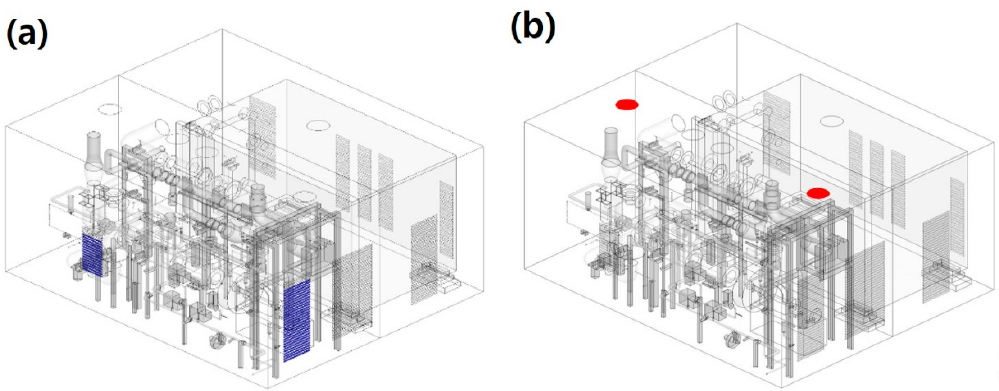
Figure 3. Conditions of the inlet and outlet of the balance-of-plant (BOP) package: ( a ) louver installation locations (inlet) and ( b ) exhaust pipe locations (outlet). Table 1. Heat flux of the heating area of the stack package